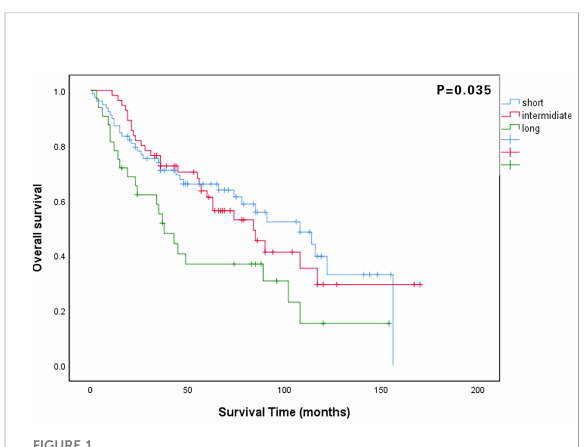
FIGURE 1 Comparison of overall survival curves among patients in the long, intermediate, and short waiting time